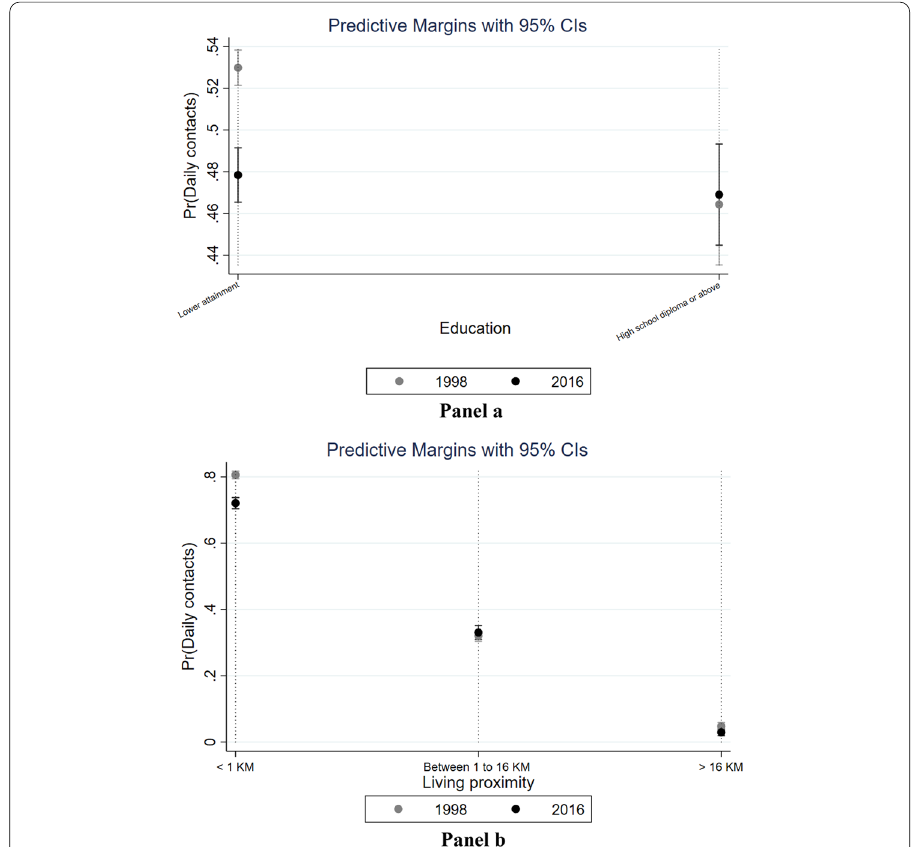
Fig. 2 Predicted probabilities daily contacts—changes over